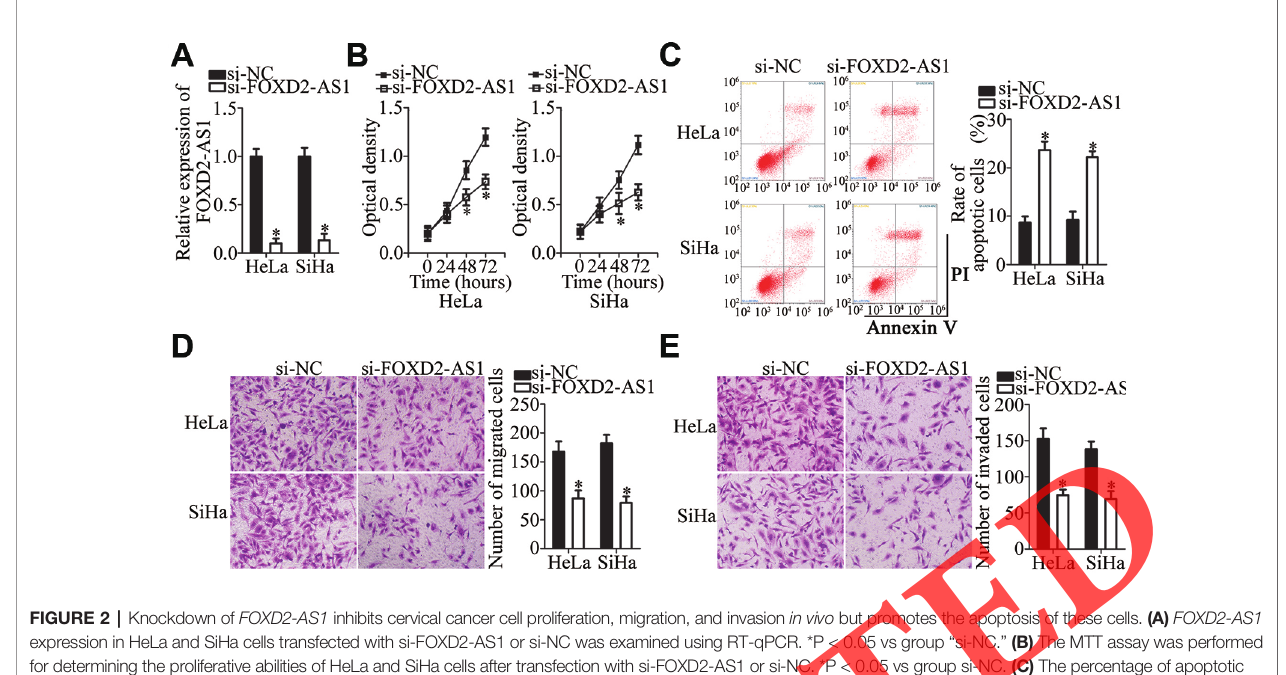
FIGURE 2 | Knockdown of FOXD2-AS1 inhibits cervical cancer cell proliferation, migration, and invasion in vivo but promotes the apoptosis of these cells. (A) FOXD2-AS1 expression in HeLa and SiHa cells transfected with si-FOXD2-AS1 or si-NC was examined using RT-qPCR. *P < 0.05 vs group “ si-NC. ” (B) The MTT assay was performed for determining the proliferative abilities of HeLa and SiHa cells after transfection with si-FOXD2-AS1 or si-NC. *P < 0.05 vs group si-NC. (C) The percentage of apoptotic FOXD2-AS1 -de fi cient HeLa and SiHa cells was assessed by fl ow cytometry. *P < 0.05 vs the si-NC group. (D, E) Migration and invasion assays were conducted to analyze the effects of FOXD2-AS1 inhibition on the migratory and invasive abilities of HeLa and SiHa cells. *P < 0.05 vs group